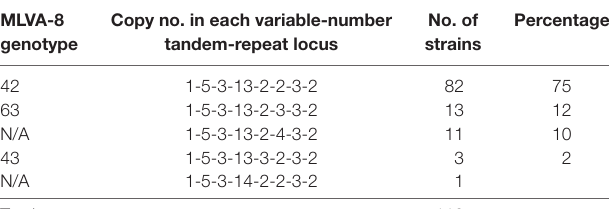
TaBle 1 | MLVA-8 genotypes identified in 110 Chinese Brucella melitensis